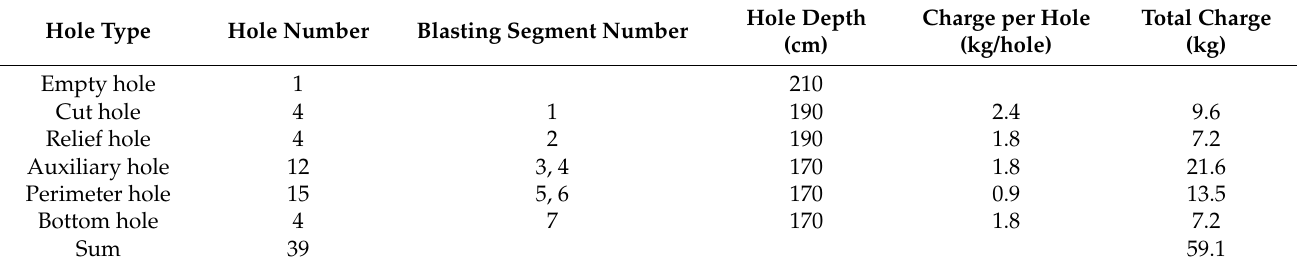
Figure 2. Layout of the blasting hole.